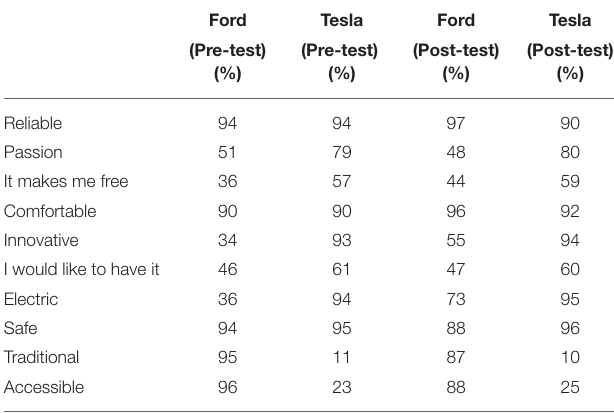
TABLE 3 | FoA expressed in percentage of the number of “yes” answers over the total sample (80 subjects exposed to the Ford website). Ford Tesla